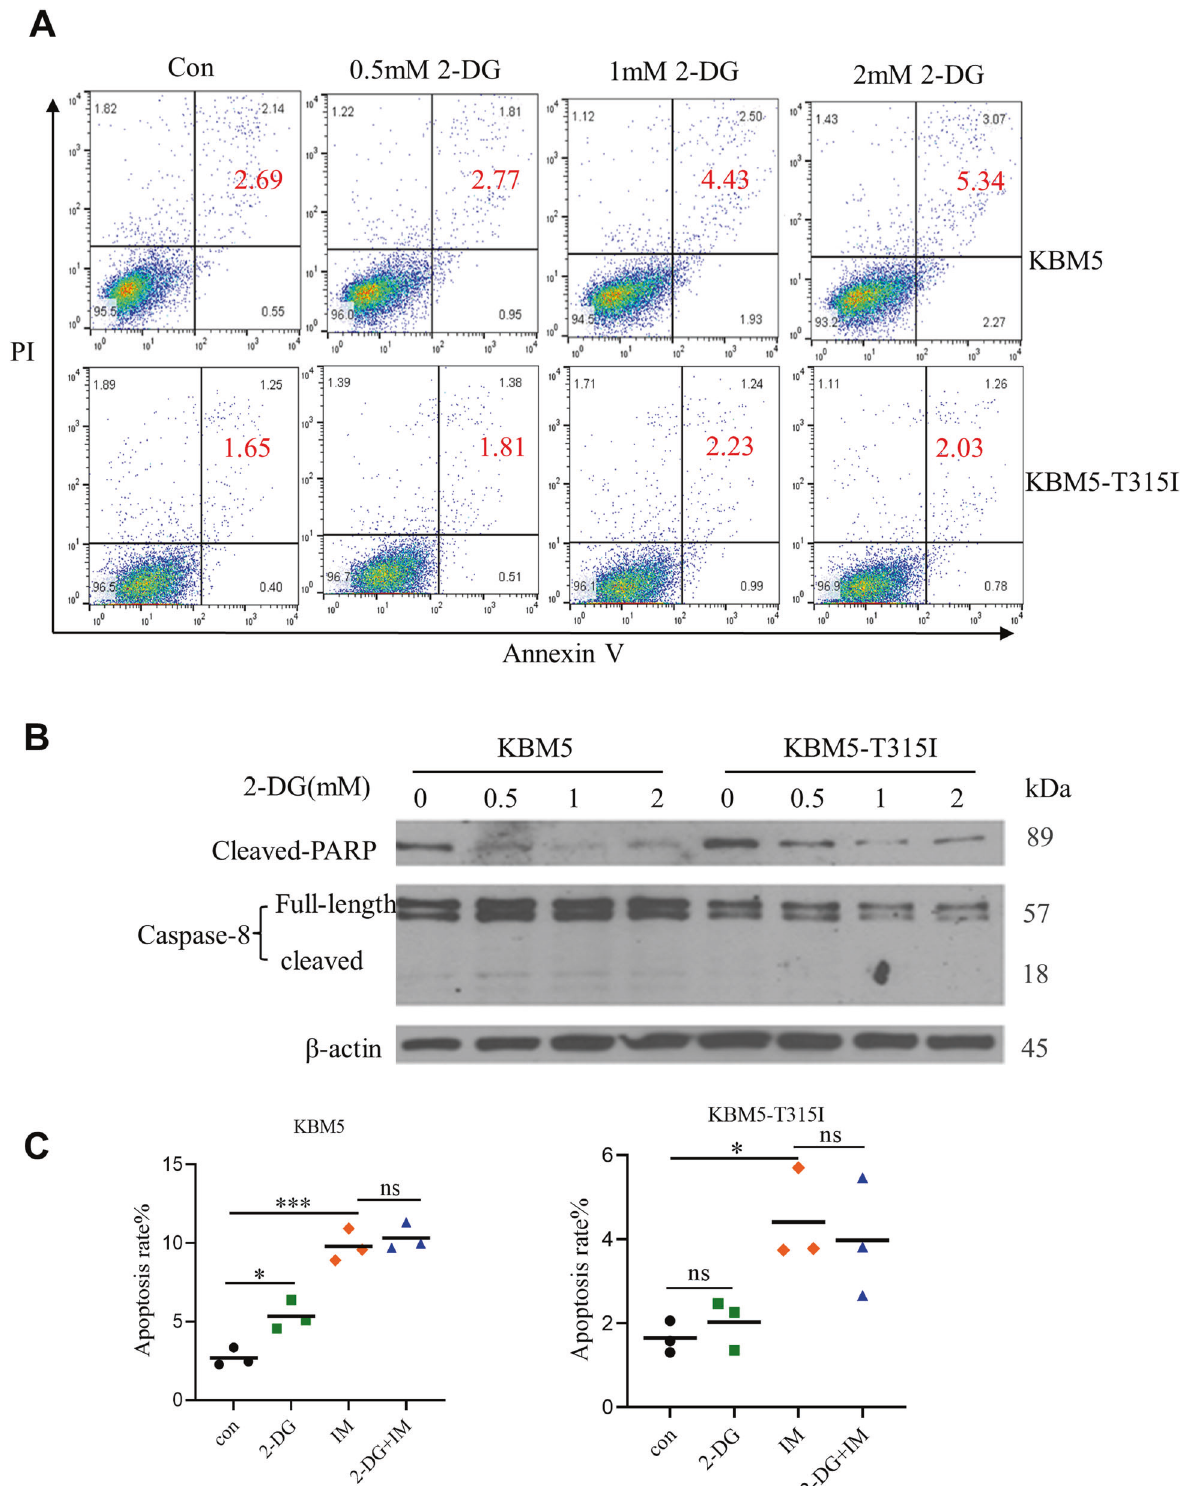
Fig. 2 2-DG induces CML cell death in an apoptosis-independent pathway. A KBM5 and KBM5-T315I cells were treated with indicated concentrations of 2-DG for 48h, and cell viability was measured by Annexin V-FITC/PI staining and fl ow cytometry analysis. The result from a representative experiment is shown. The number (%) within each fl ow cytometry panel indicates % of dead cells (Annexin V-FITC/PI double-positive). B Western blotting analysis of cleaved PARP and cleaved/full-length caspase-8 before and after 2-DG treatment. KBM5 and KBM5-T315I cells were treated with 2-DG at the indicated concentrations for 48h, and proteins were isolated for western blotting analysis of cleaved-PARP, cleaved/full-length caspase-8 and β -actin. C Apoptosis analysis of CML cells in response to 2-DG and/or IM treatment. Quantitative results of three separate experiments are shown. Each bar shows mean±SD, * P <0.05, *** P <0.001, ns not signi fi cant.